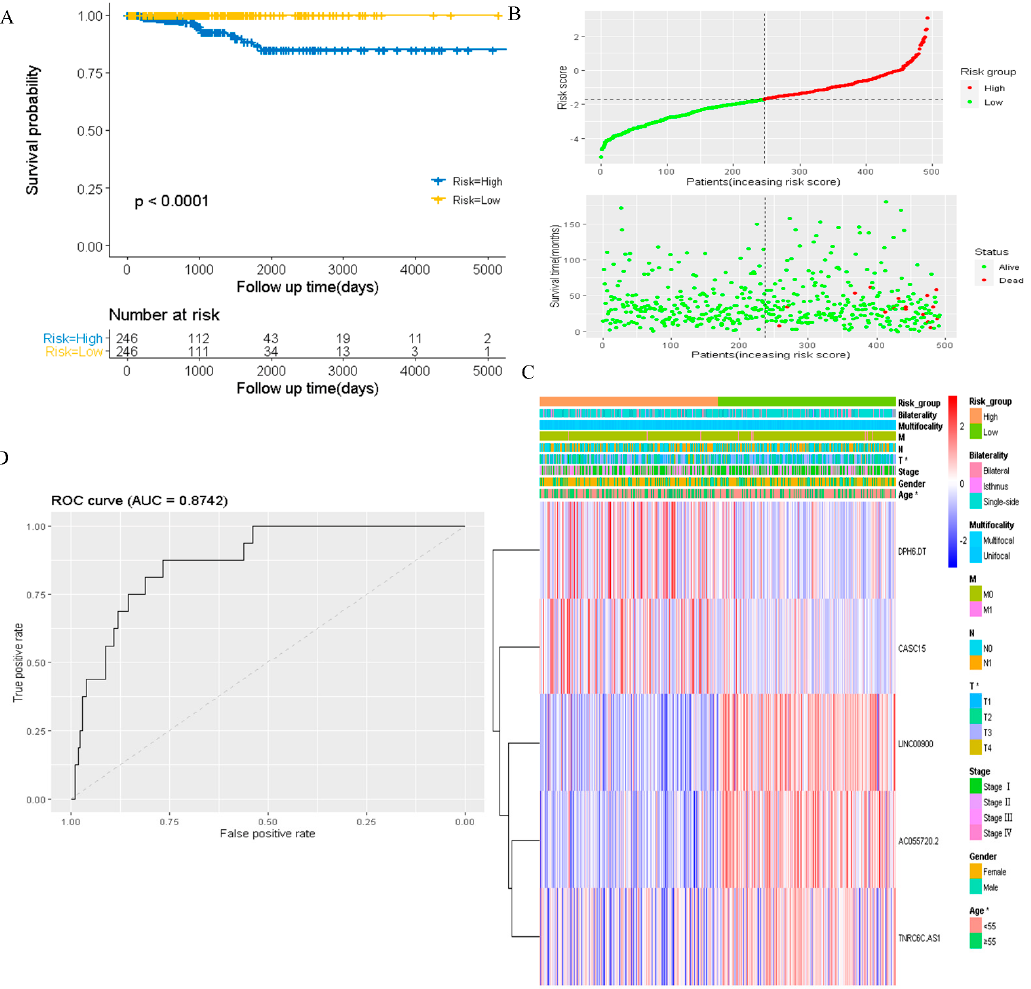
Figure 3. Prognostic value of risk score. ( A ) Survival analysis of patients in the low-risk and high-risk groups. ( B ) Distributions of survival status and risk scores. ( C ) Heatmap distribution of risk scores and clinicopathological characteristics of the two groups. ( D ) The AUC of the risk score. AUC: the area under the receiver operating characteristic curve.